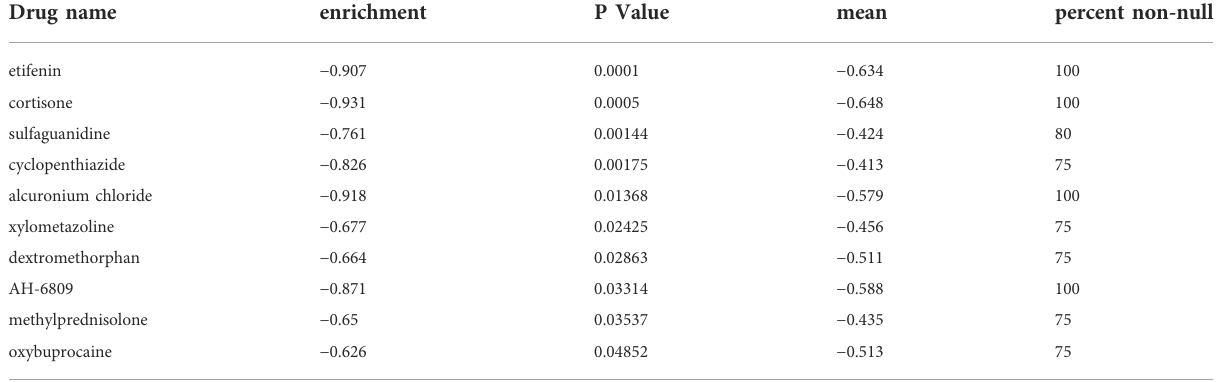
TABLE 2 Potential small molecular drugs targeting high-risk OSCC